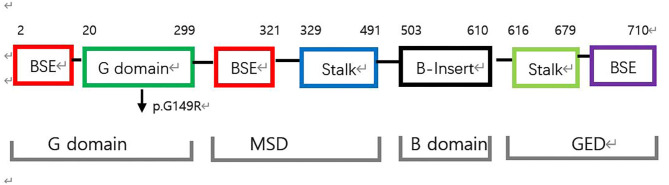
Structure-based domain architecture of human DNM1L. The first and last residue of each domain are labeled. The classical predicted domain assignments including the G domain, middle assembly domain (MSD), B domain, and the GTPase effector domain (GED) are shown below. The mutation p.G149R was located at the G domain (black arrow).